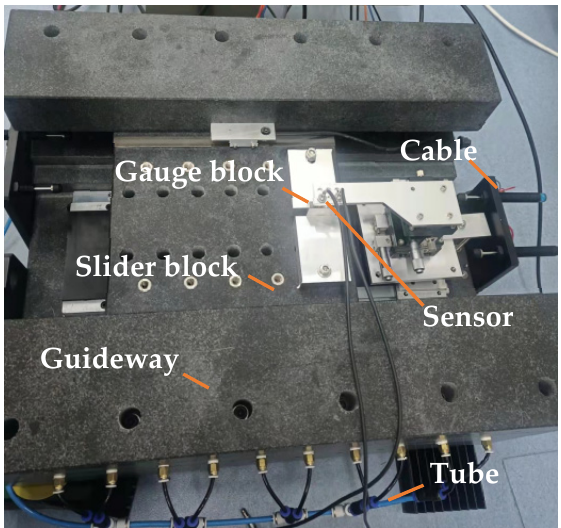
Figure 16. The realized experimental equipment of the cableless aerostatic guideway.